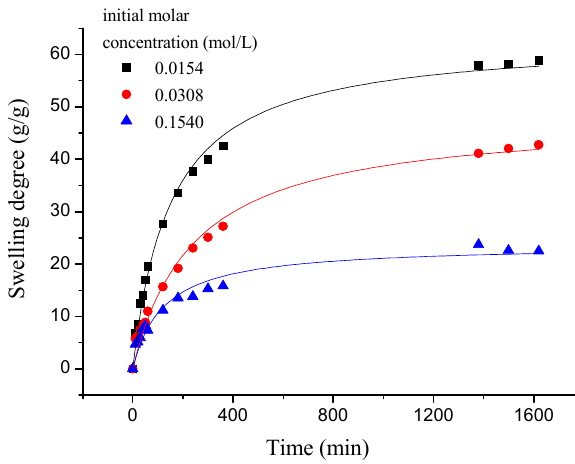
Figure 8. The swelling kinetics of γ -PGA/ ε -PL hydrogels in NaCl solution.